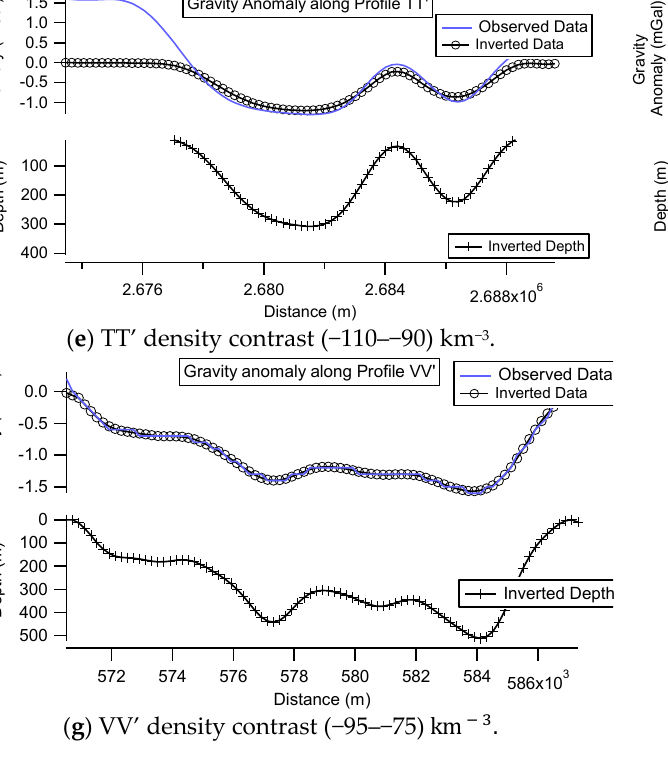
Figure 12. The observed gravity anomalies from the profiles obtained across the study area. The solid blue line presents the observed gravity field along the profiles, the line-through-circles symbol represents the inverted gravity field, and the line-through-crosses symbol in the lower panel represents the inverted depths realized from the PSO computations. The density contrast ranges between − 130 and − 60 kg/m 3 . The inverted gravity data and depth results were obtained using PSO computations along Profiles PP’ ( a ), QQ’ ( b ), RR’ ( c ), SS’ ( d ), TT’ ( e ), UU’ ( f ), and VV’ ( g ). Table 2 presents the number of parameters of the Fourier coefficients for each of the selected depth profiles. The root ‐ mean ‐ square error (RMSE) values of the computed gravity anomalies are also displayed. Table 2. The predicted top basement geometry parameters with the depth range and mean depth results. The RMSE in the gravity inversion is also represented for the individual profile computa ‐ tions.